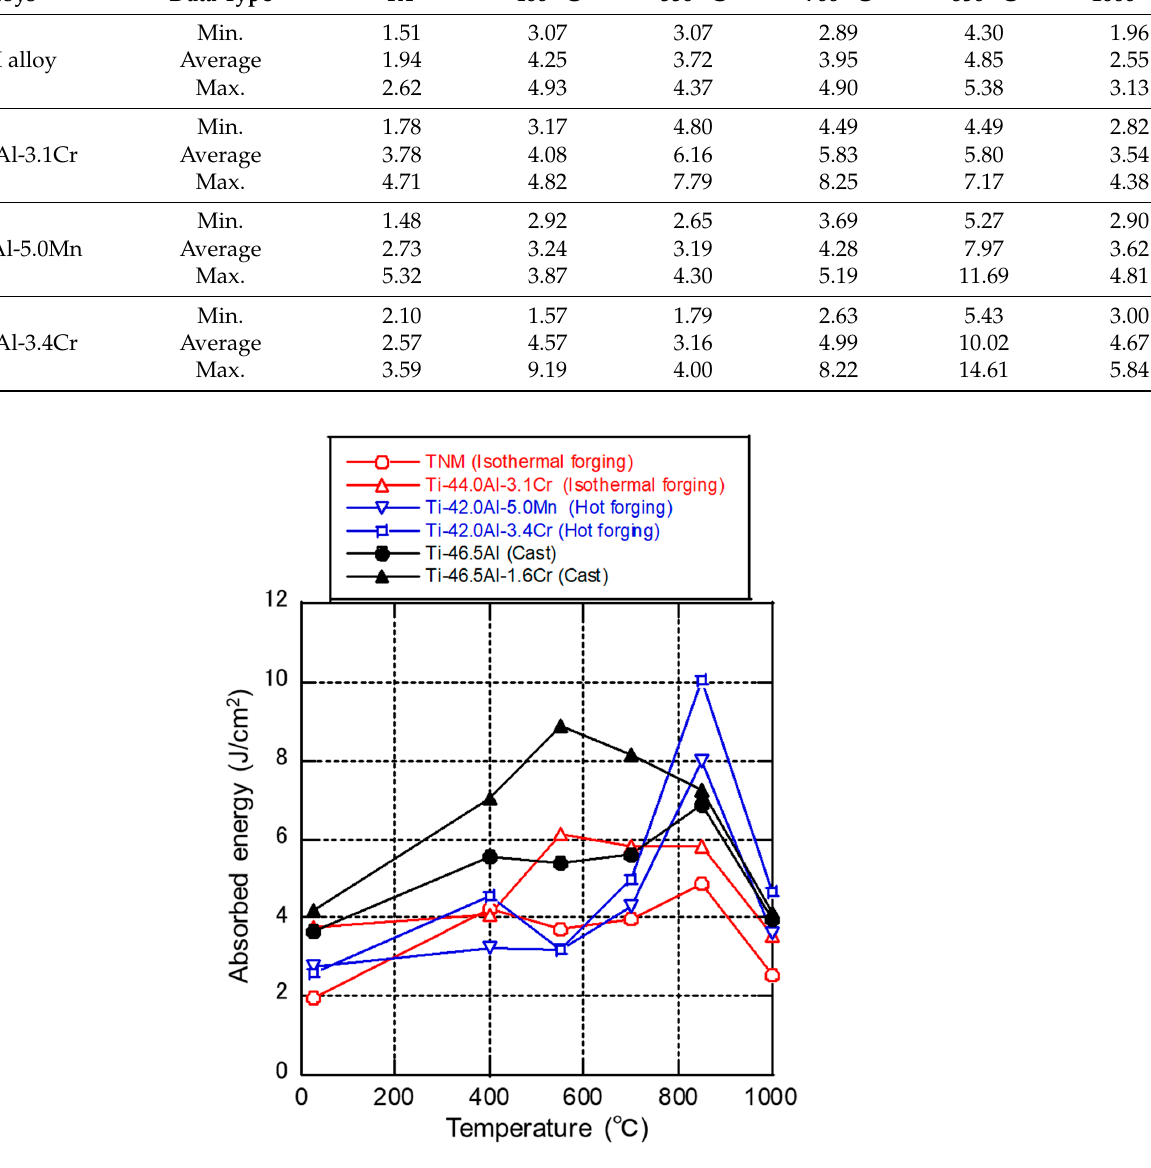
Figure 7. Comparison of average Charpy absorbed energies of forged TiAl alloys at various temperatures, as well as those of the cast Ti-46.5Al and Ti-46.5Al-1.6Cr.